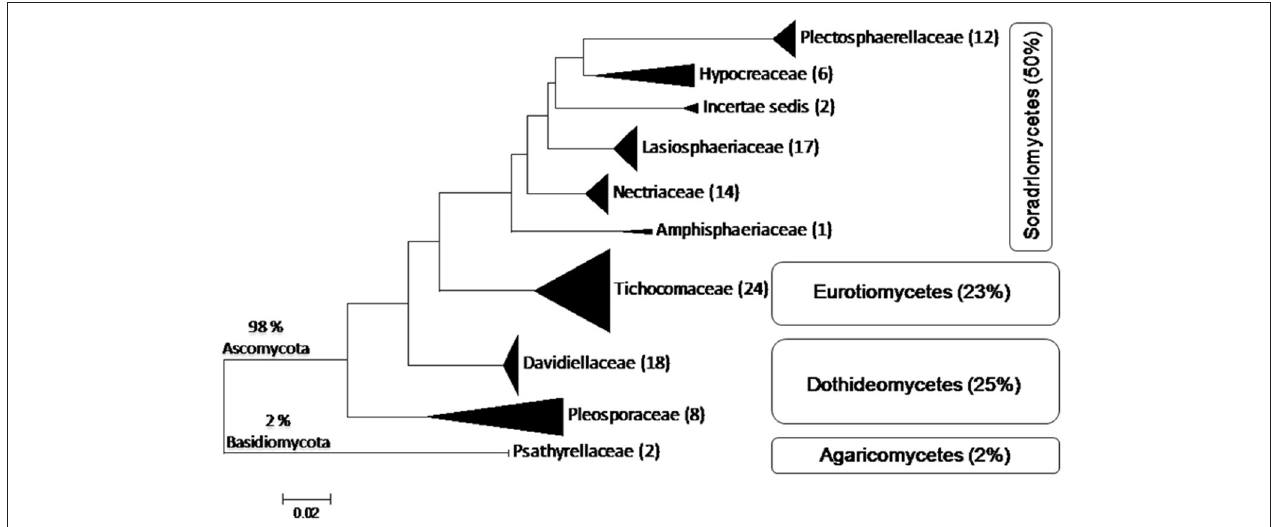
FIGURE 5 | Schematic representation of placement of 104 isolates belonging to 38 species derived from ITS sequences of fungi from Lonar lake, Buldhana, Maharashtra, India. Classification follows Hibbett et al. (2007). All isolates belong to Ascomycota except 2% belonging to Basidiomycota . The isolates of Ascomycota are distributed among three classes, Sordariomycetes, Dothideomycetes , and Eurotiomycetes . Percentages indicate the total number of isolates out of the 104 isolated fungi.